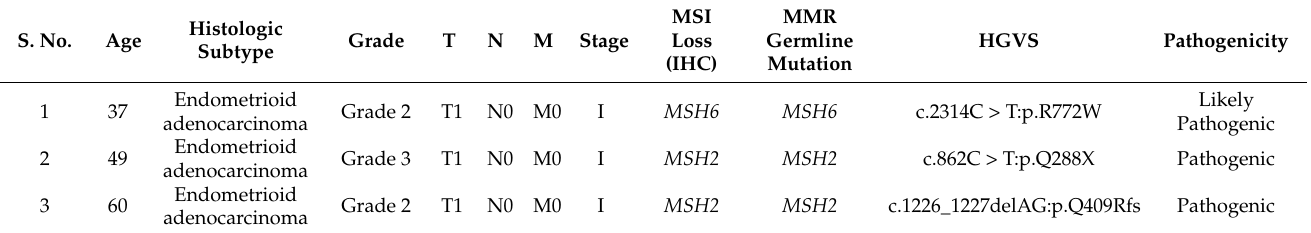
Table 2. Clinicopathological characteristics of three Lynch syndrome cases in endometrial